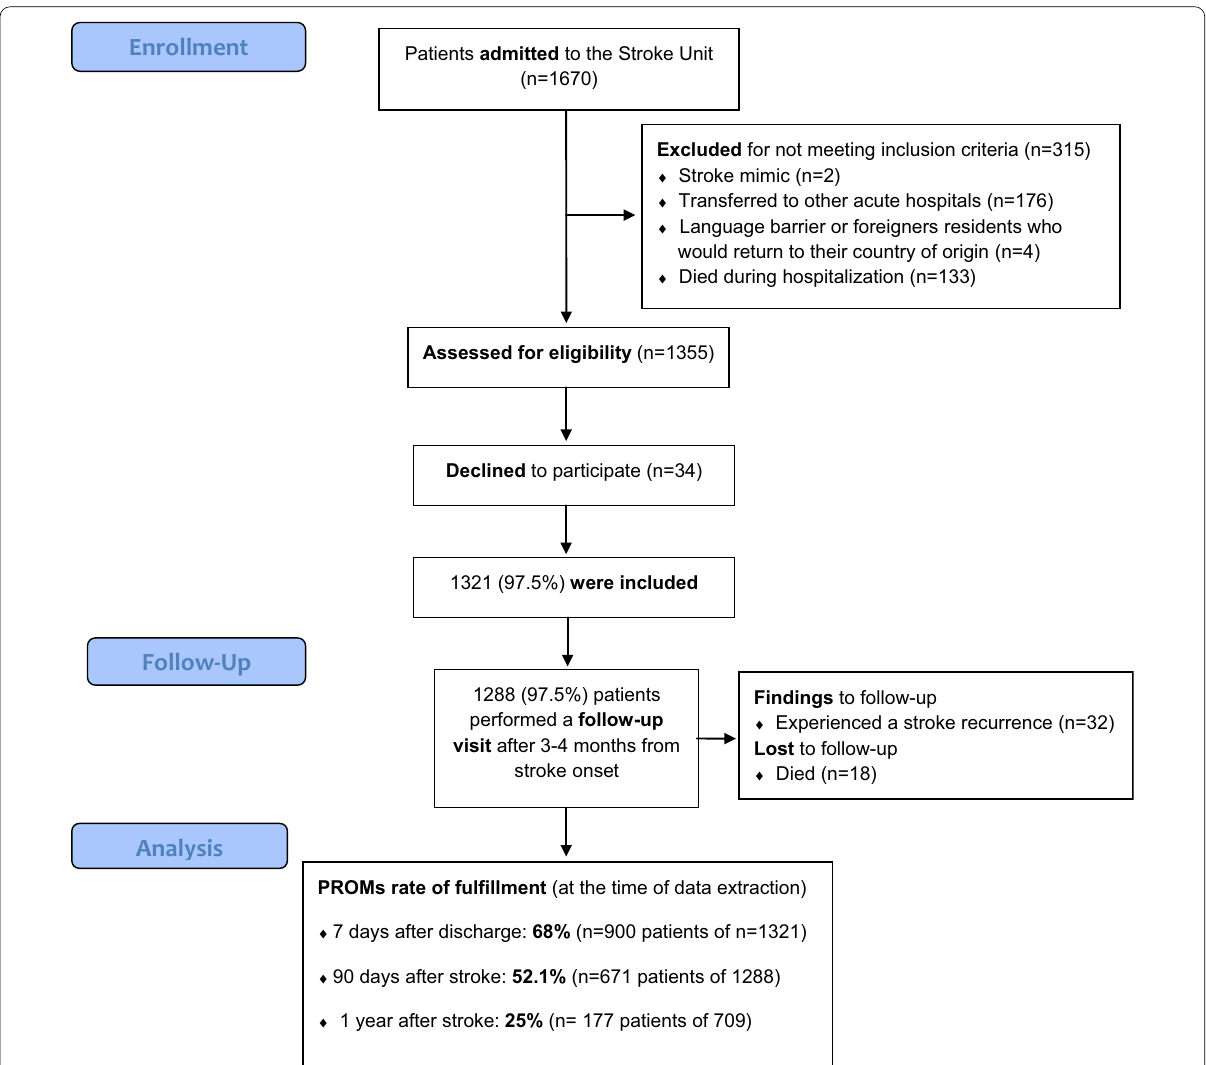
Fig. 1 Flowchart of all patients admitted to the Stroke Unit and PROMs fulfillment rate at the time of data extraction of patients that were finally